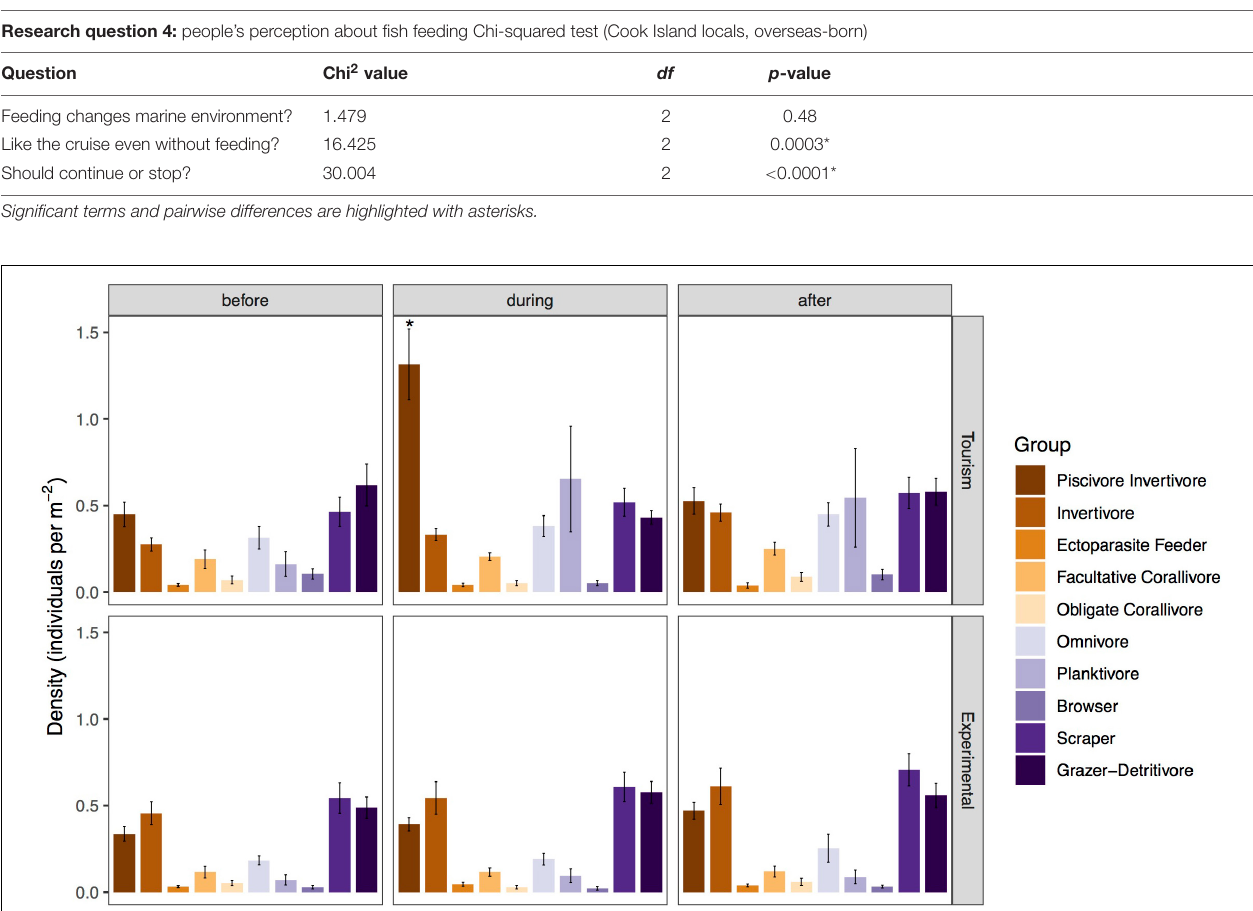
FIGURE 3 | Mean density ( ± SE) of fish classified in feeding groups before, during, and after bread feeding events at tourism and experimental feeding sites. Significant differences are indicated by asterisks.